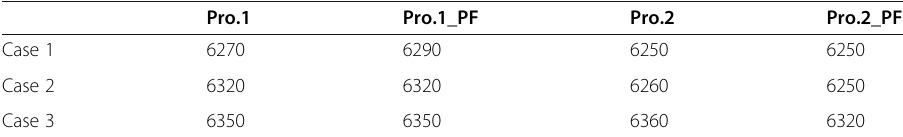
Table 6 V ref values of proposed methods (V)